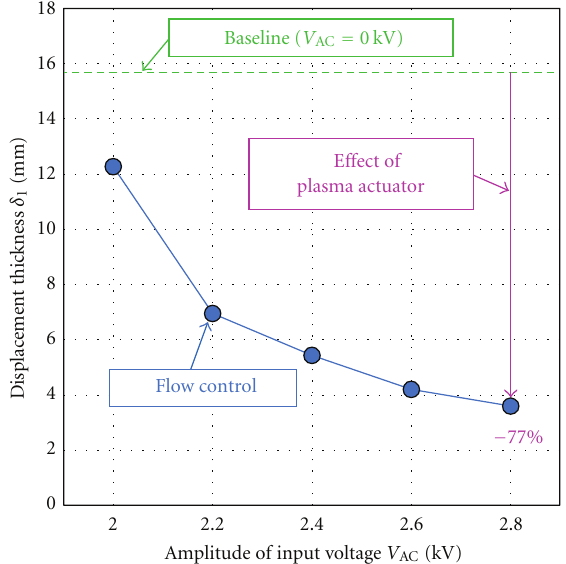
Figure 15: Displacement thickness of boundary layer near trailing edge ( x = 99.1